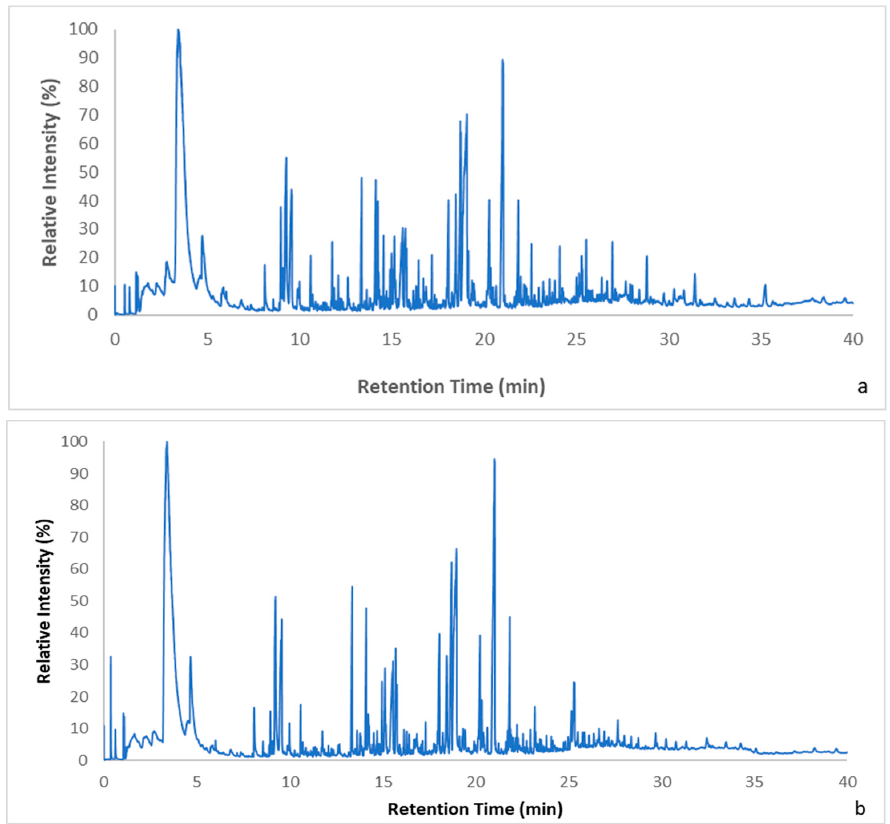
Figure 6. GC/MS chromatograms after pyrolysis of the blends without pretreatment for blend I ( a ) and blend II ( b ).